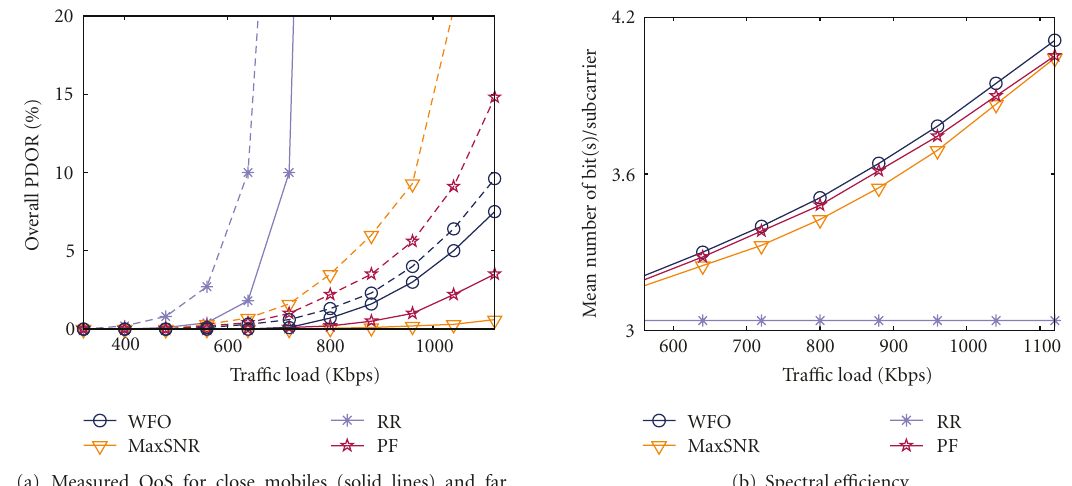
Figure 12: Performances of schedulers with fixed multiuser diversity.